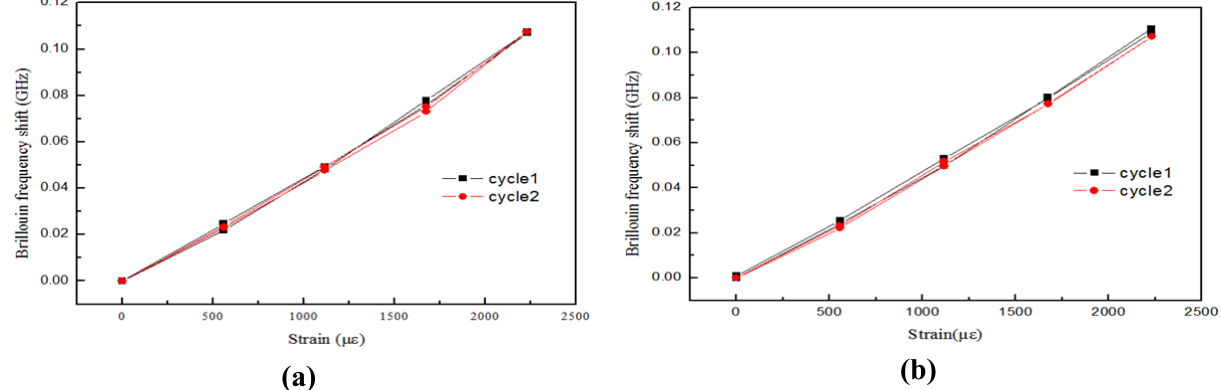
Figure 12. (a) Strain sensitivity result of sensor with length of 1 m; (b) Strain sensitivity result of sensor with length of 2 m.